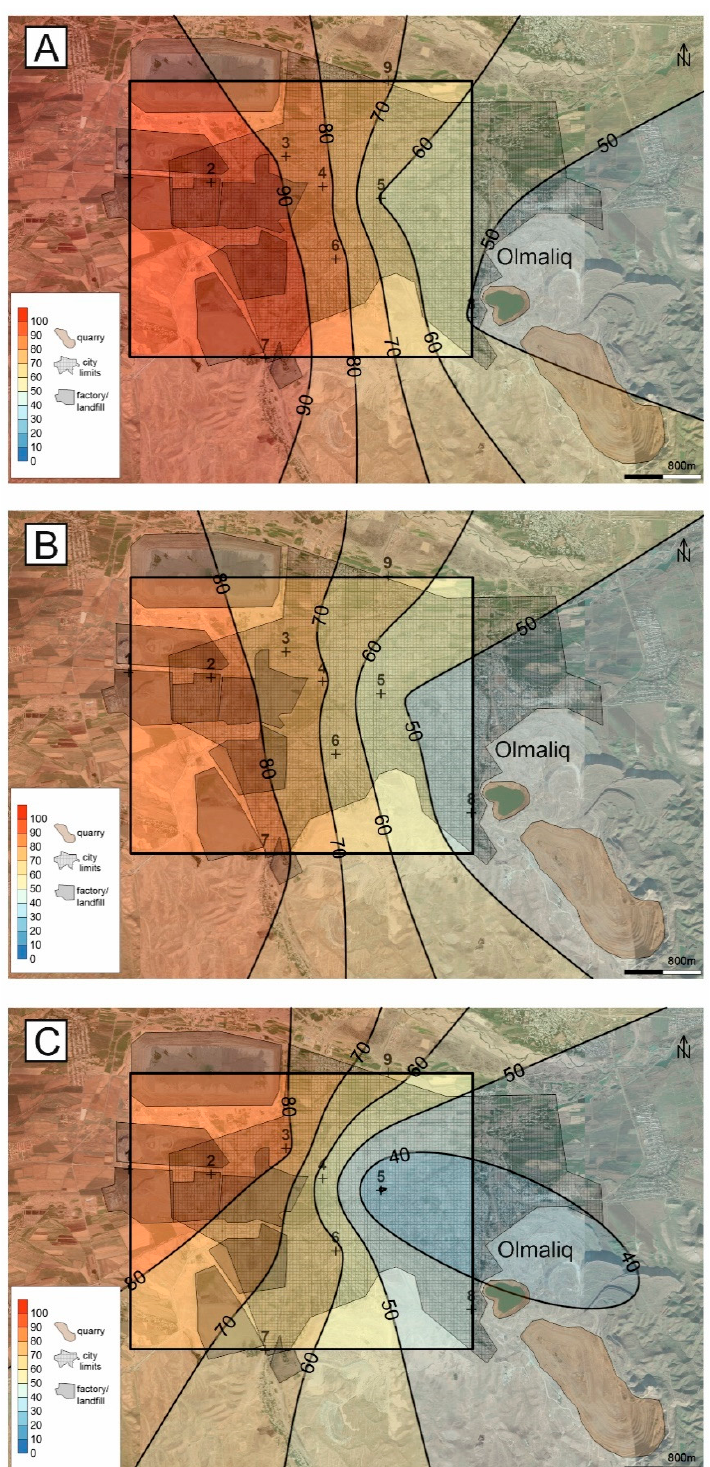
Figure 6. Spatial distribution of atmospheric particles of inorganic anthropogenic origin deposited on Populus nigra Italica leaves collected in August 2018 in the vicinity of Olmaliq city. Percentage contribution of anthropogenic origin particles: ( A ) below 2.5 μ m; ( B ) between 2.5 and 10 μ m, and ( C ) above 10 μ m. The bright colors presented in the drawn rectangle area are covered with sampling points/data, whereas the bleached area outside the rectangle shows extrapolated data only.